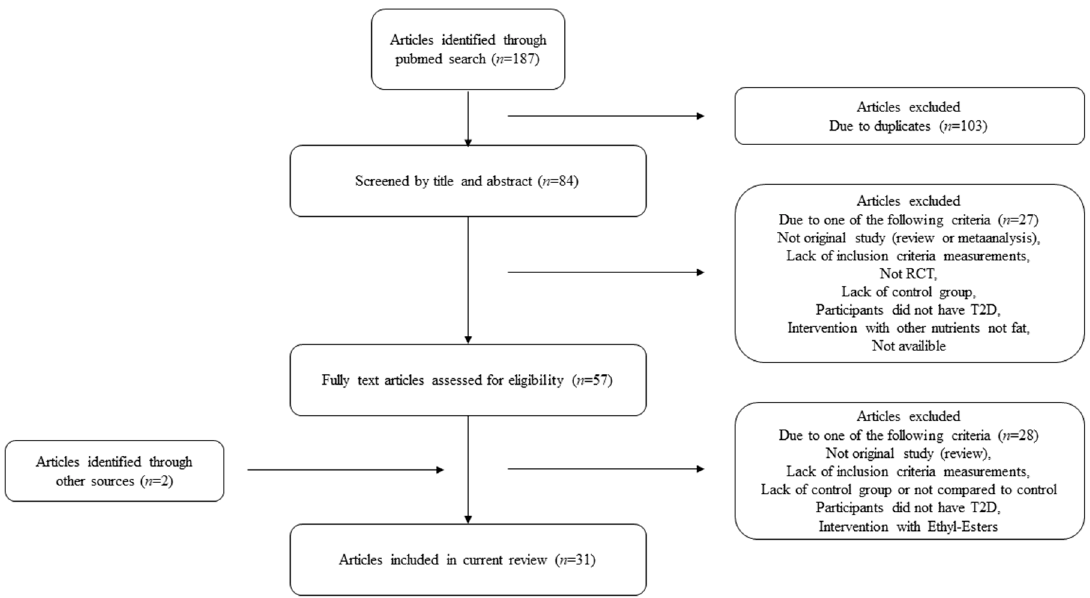
Figure 1. Flow chart of the study selection. RCT: randomized controlled trial; T2D: type 2 diabetes.